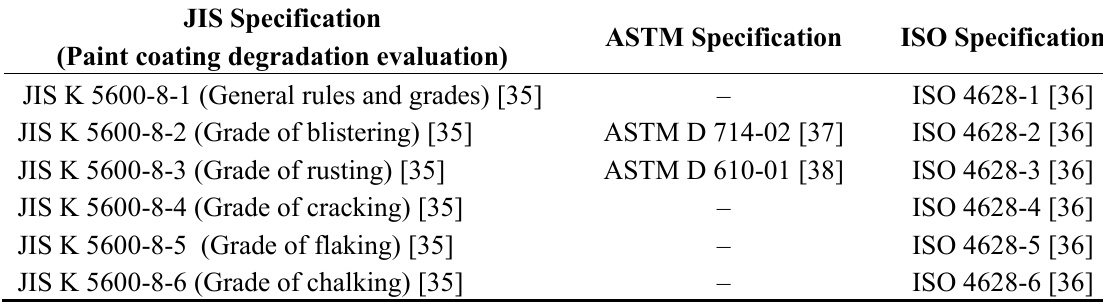
Table 1. JIS, ASTM, ISO specification of paint coating